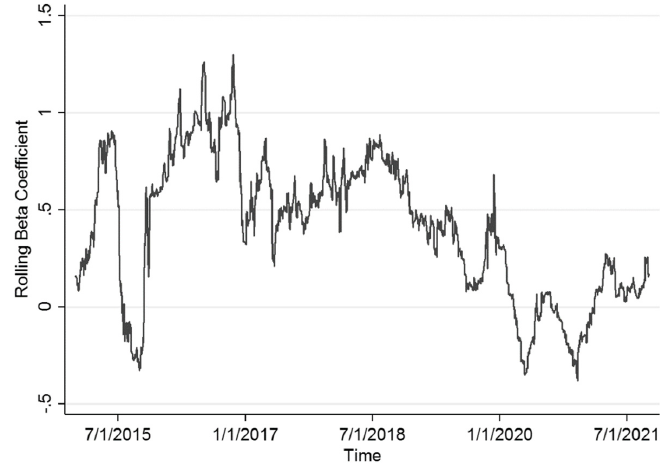
Figure 3. Common shock (rolling) impact on the Intesa San Paolo performance: period January 2015– December 2021. Source: authors’ calculation in Stata on Bloomberg data.